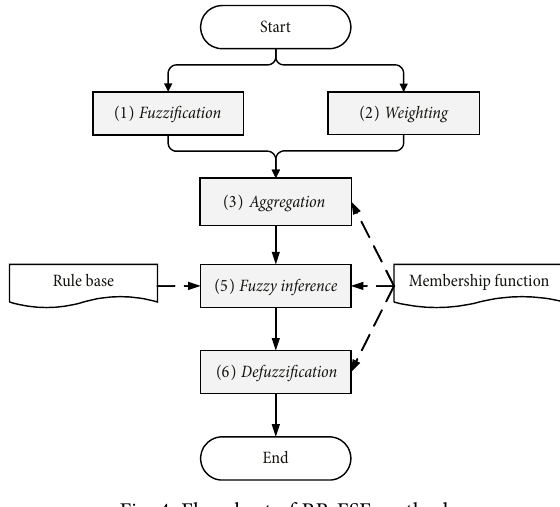
Fig. 4. Flowchart of RB-FSE method